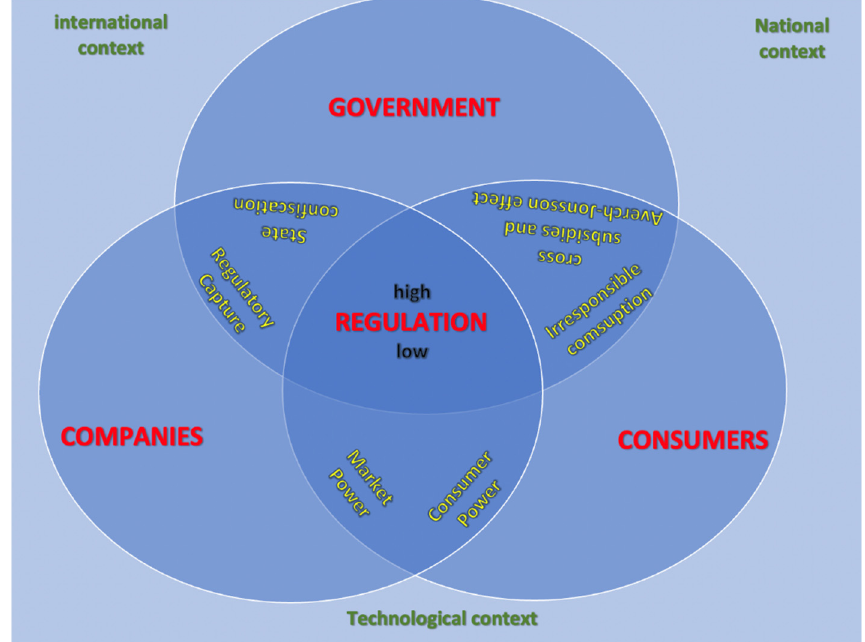
Figure 1. The simplified dynamics of the regulation game and some of its risks. Note: The main players are in red, the contextual factors in green, and some of the regulatory risks in yellow. Source: Elaboration by the author.